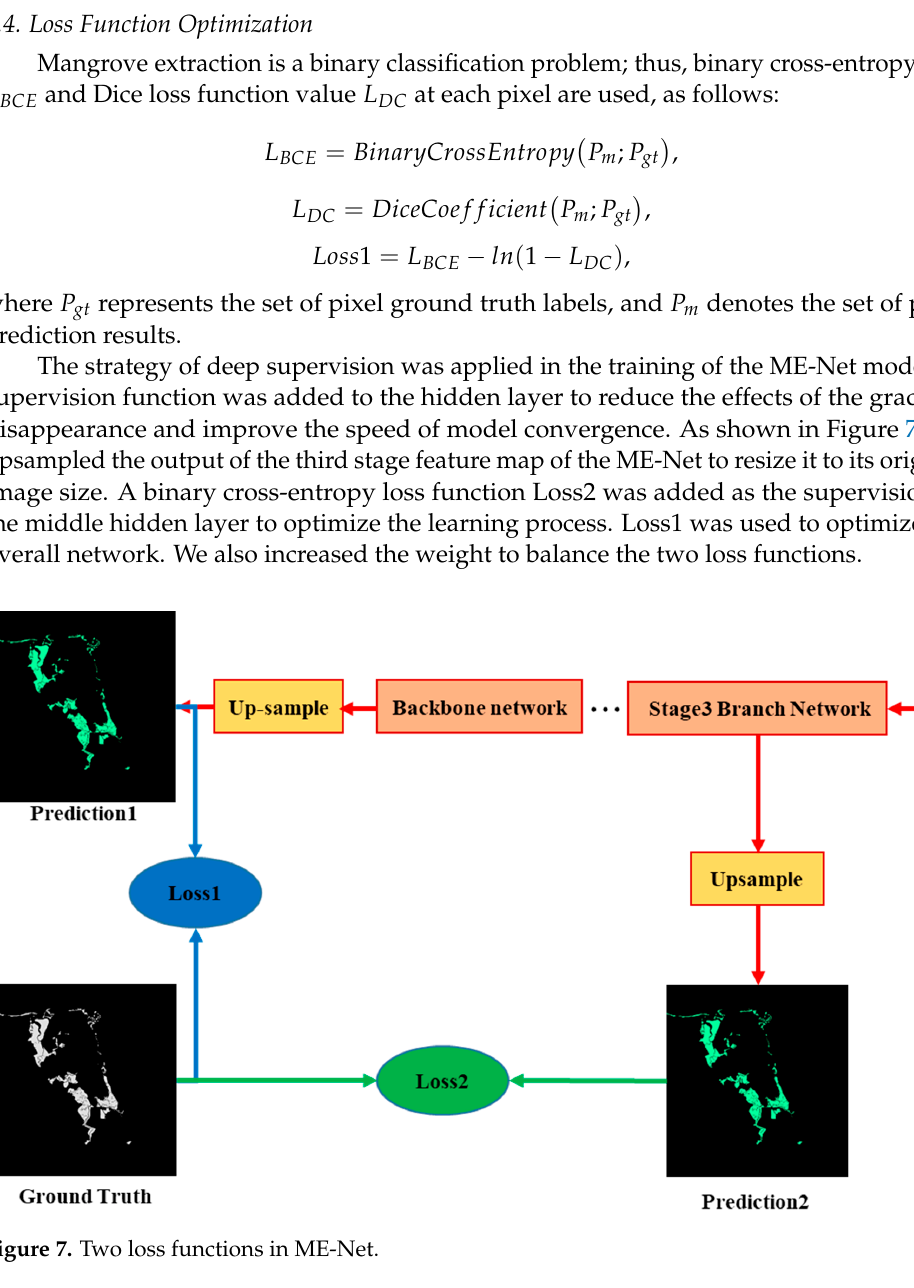
Figure 6. BFU architecture. The green box is the feature map, the yellow rectangle is the convolution operation, the brown rectangle is the batch normalization(BN) operation, the orange ellipse is ReLU, “+” represents that a feature map with the same size is added in accordance with the pixel position, the blue arrow represents the skipped connection, and the red box represents the feature mapping.